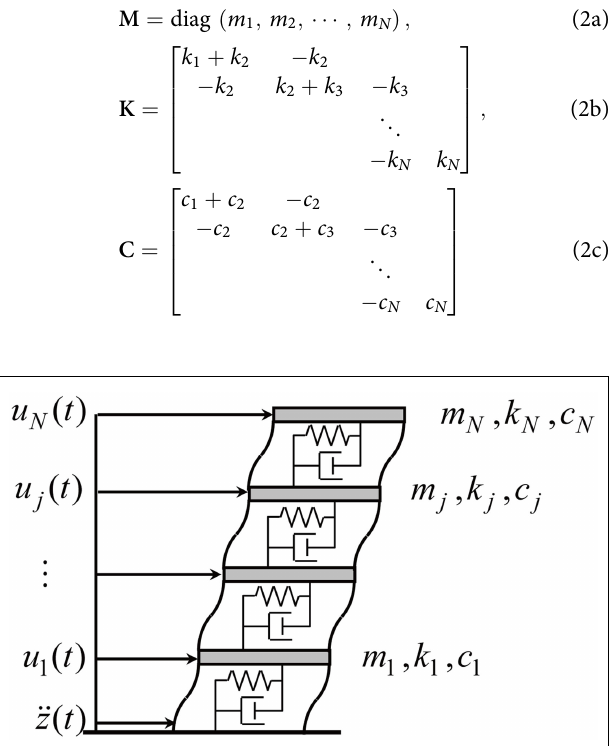
FIGURE 1 | N -story shear building model with viscous damping